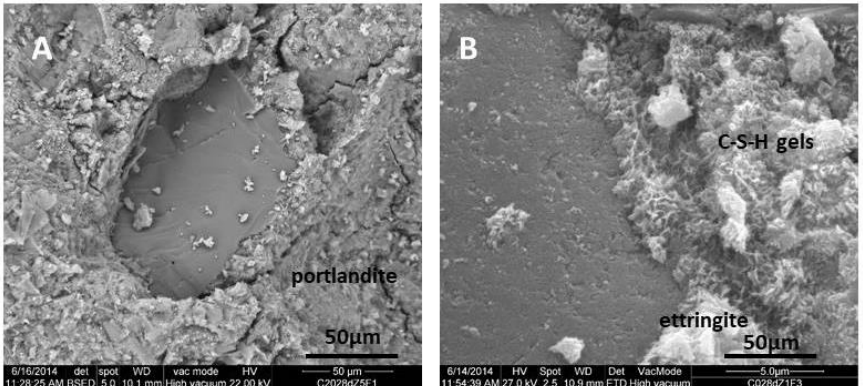
Figure 6. Macroporosity quantification (in % of pore volume) grouped into three pore volume ranges (>0.09 mm 3 , <0.09 mm 3 , >0.001 mm 3 , <0.001 mm 3 ) for PR-1 sample.